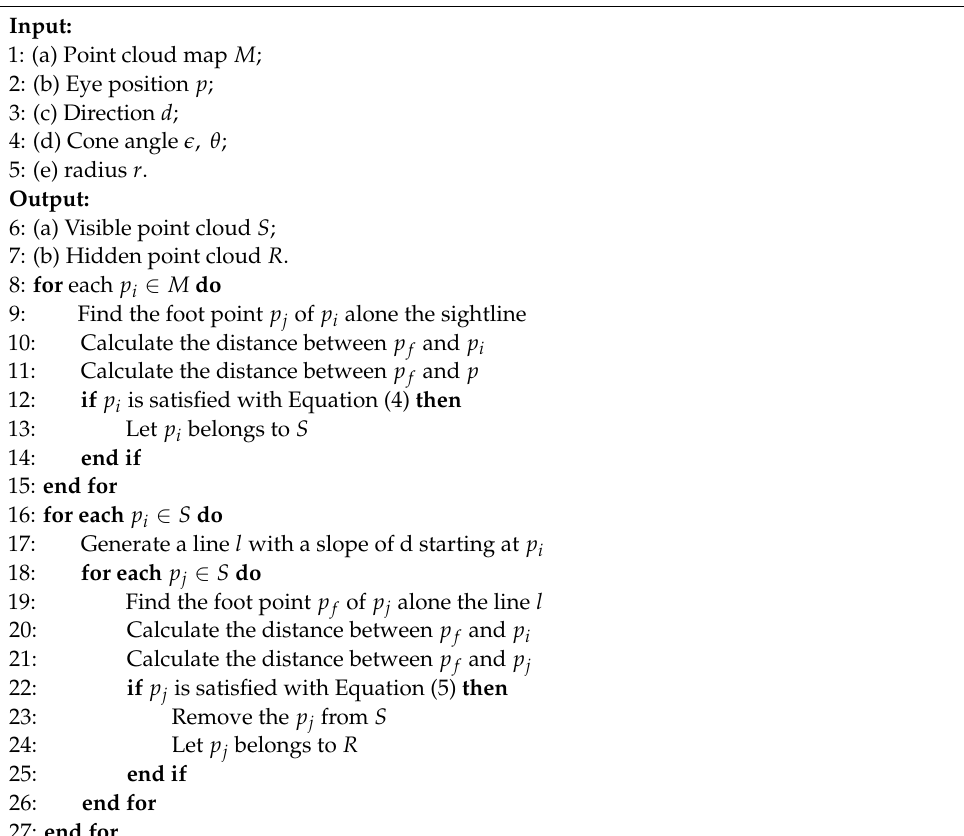
Algorithm 1 Finding Visible Point